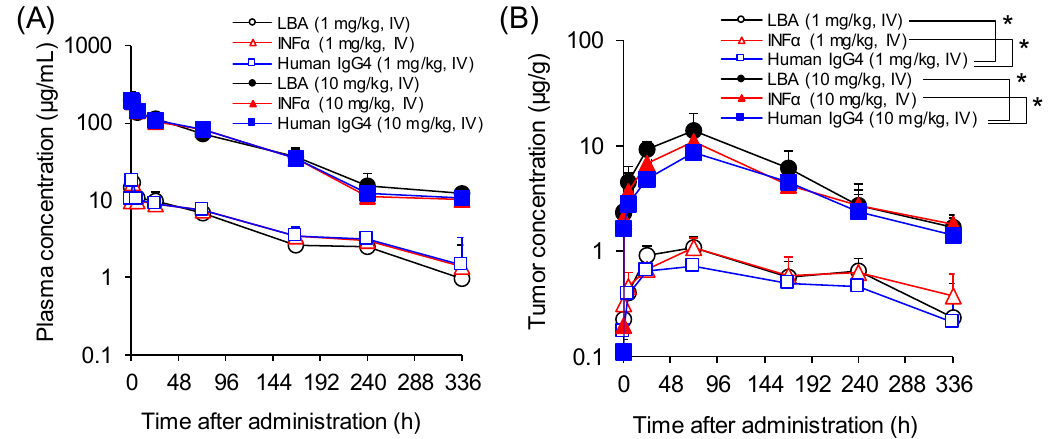
Figure 3. Plasma ( A ) and tumor ( B ) concentration versus time profile in mice after a single i.v. administration of TFP. The plasma and tumor concentration versus time profile in mice, after a single i.v. administration of the TFP at doses of 1 and 10 mg / kg, determined by LBA (circle), IC-LC / MS assay using interferon alpha specific peptide (triangle) and human IgG4 generic peptide (square). The values were expressed as mean + S.D. ( n = 3). Data were analyzed by one-way ANOVA followed by Dunnett’s post hoc test. Statistically significance* was set at p < 0.05 for all tests. Table 2. The comparison of pharmacokinetic parameter based on LBA and IC-LC / MS-based assay.